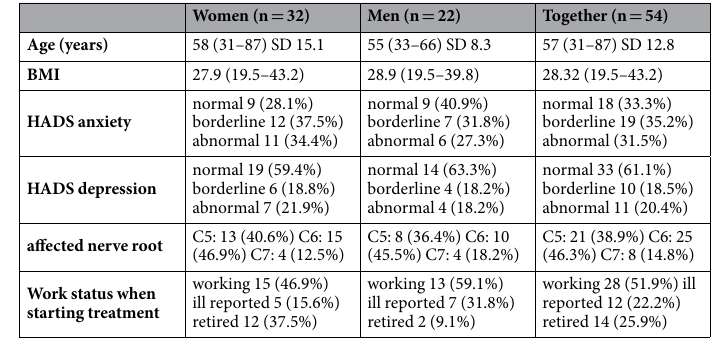
Table 1. Demographic data of the patient group (mean and